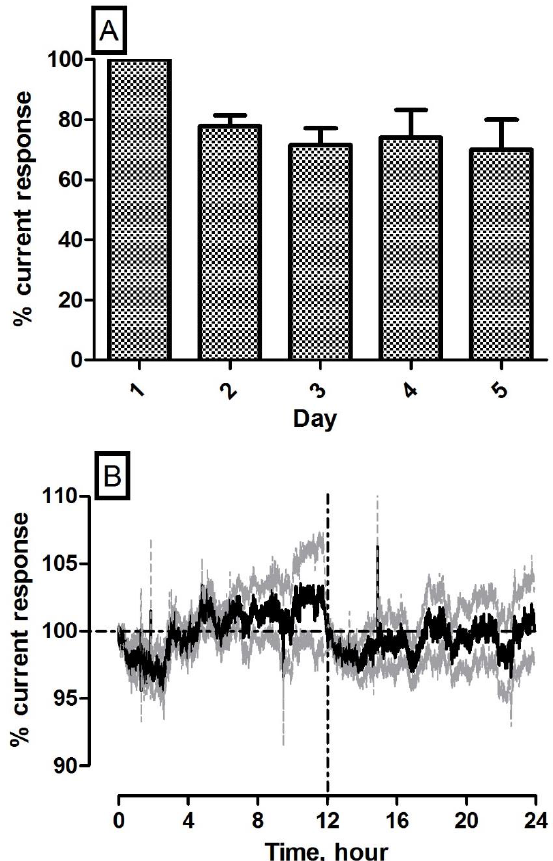
Figure 6. ( A ) Average percentage baseline in vivo data ( n = 6) for subtracted H 2 O 2 biosensor recorded in the striatum of NOD SCID mice. Percentage current response data represented as mean ± SEM. ( B ) Averaged 12-h raw data percentage response (lights on (0–12 h), n = 14/7), lights off (12–24 h), n = 17/7) of subtracted H 2 O 2 current from biosensors implanted in the striatum of NOD SCID mice. Mean percentage current response represented by black trace, percentage error represented by grey trace.